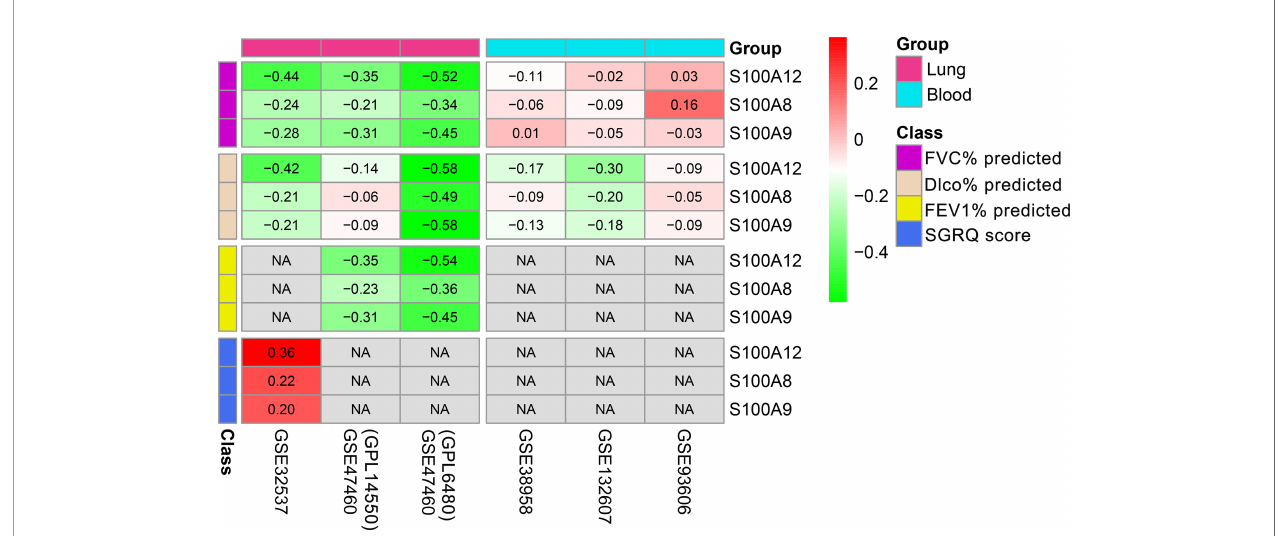
FIGURE 4 | Correlation between 3 genes (S100A12, S100A8, and S100A9) and lung function or SGRQ score in the lung and blood of patients with IPF. NA, not